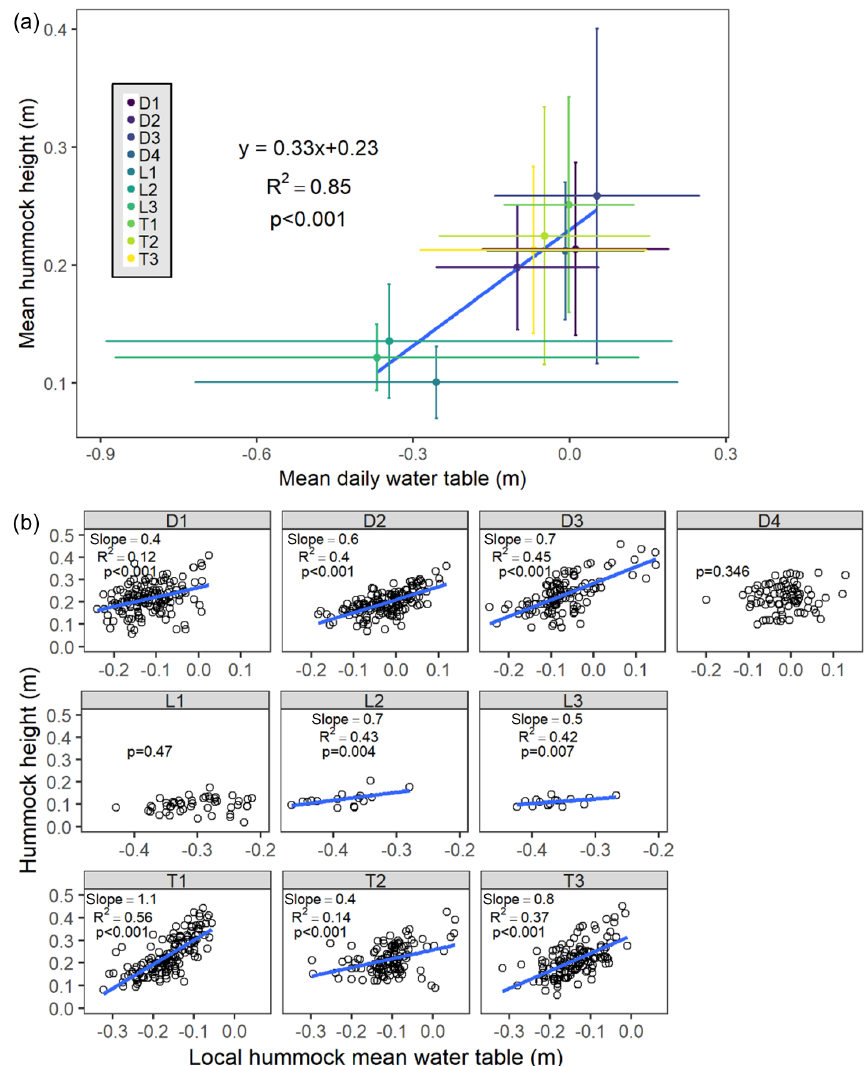
Figure 7. Hummock height as a function of mean water level. (a) Mean site-level hummock height ( ± SD) versus mean site-level daily water level ( ± SD), and (b) individual hummock height versus local daily mean water level. The slope, R 2 , and p values for the best-fit linear model (blue line) are